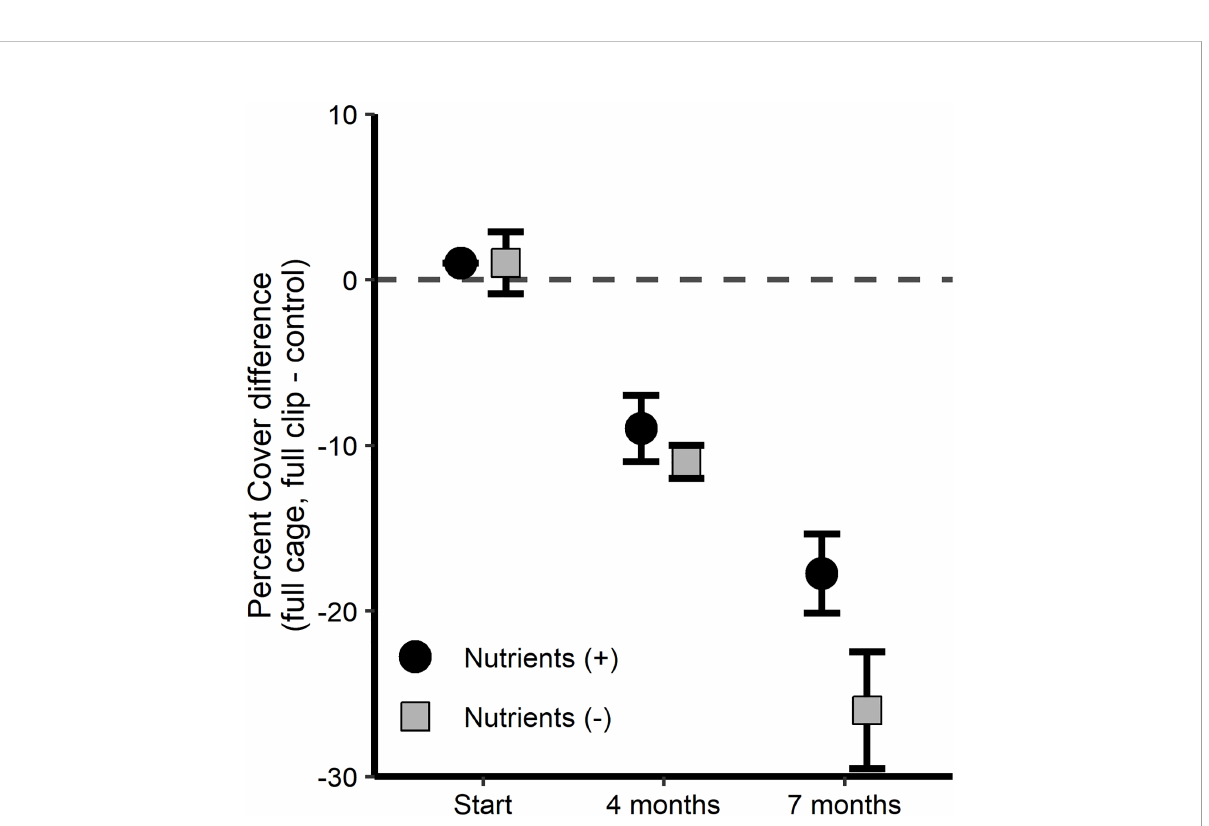
FIGURE 9 Thalassia testudinum percent cover treatment-control values (± 1 SE) for the full exclusion cage, full simulated grazing treatment with and without nutrient enrichment throughout the caging study.